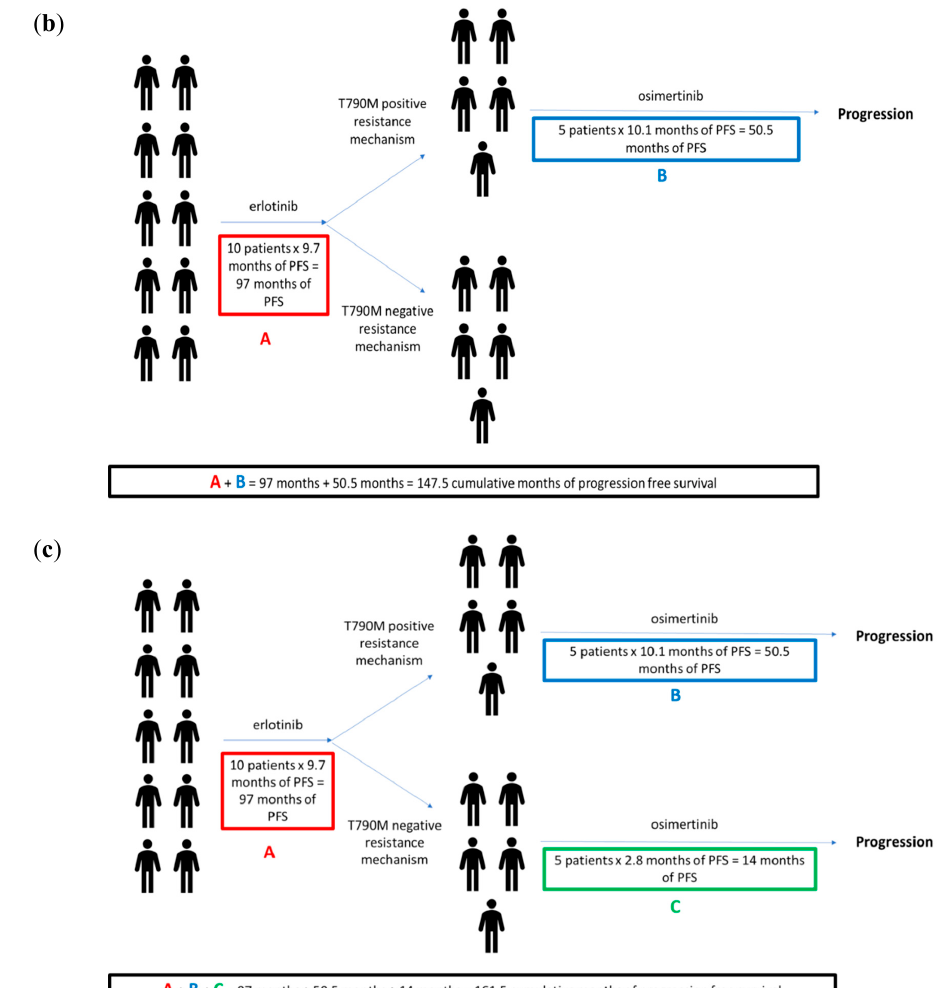
Figure 2. Comparison of cumulative months of progression free survival in theoretical cohorts of 10 patients treated with two sequencing strategies. ( a ) A theoretical cohort of 10 patients with advanced EGFR mutant NSCLC treated with osimertinib in the first line using the median PFS observed in the FLAURA trial. The estimated cumulative duration of the response for the entire cohort is calculated below. ( b ) The paradigm of sequential therapy in which a theoretical cohort of 10 patients with advanced EGFR mutant NSCLC treated with erlotinib in the first line followed by osimertinib if T790M-positive mutational status was present after disease progression. The median progression-free survival (PFS) for erlotinib in the first line was derived from the EURTAC trial [15]. The median PFS for osimertinib after progression on early-generation EGFR TKIs in T790M-positive patients was derived from the AURA3 trial. The median PFS for osimertinib after progression on EGFR TKIs in T790M-negative patients was derived from the AURA trial [60]. The estimated cumulative duration of response for the cohort of patients was calculated for each therapeutic step and for the entire treatment course. ( c ) A theoretical cohort of 10 patients with advanced EGFR mutant NSCLC treated with erlotinib in the first line followed by osimertinib regardless of their T790M mutational status after disease progression as part of the paradigm of sequential therapy. The estimated cumulative duration of response for the cohort of patients was calculated for each therapeutic step and for the entire treatment course. Acknowledging the limitation of the cross-trial comparison, this thought experiment demonstrates that the use of later-generation osimertinib may yield an overall superior duration of response in a cohort of patients even if the overall duration of response with erlotinib followed by osimertinib (9.7 months + 10.1 months = 19.8 months) in an individual patient was longer than that seen in osimertinib in the first line (18.9